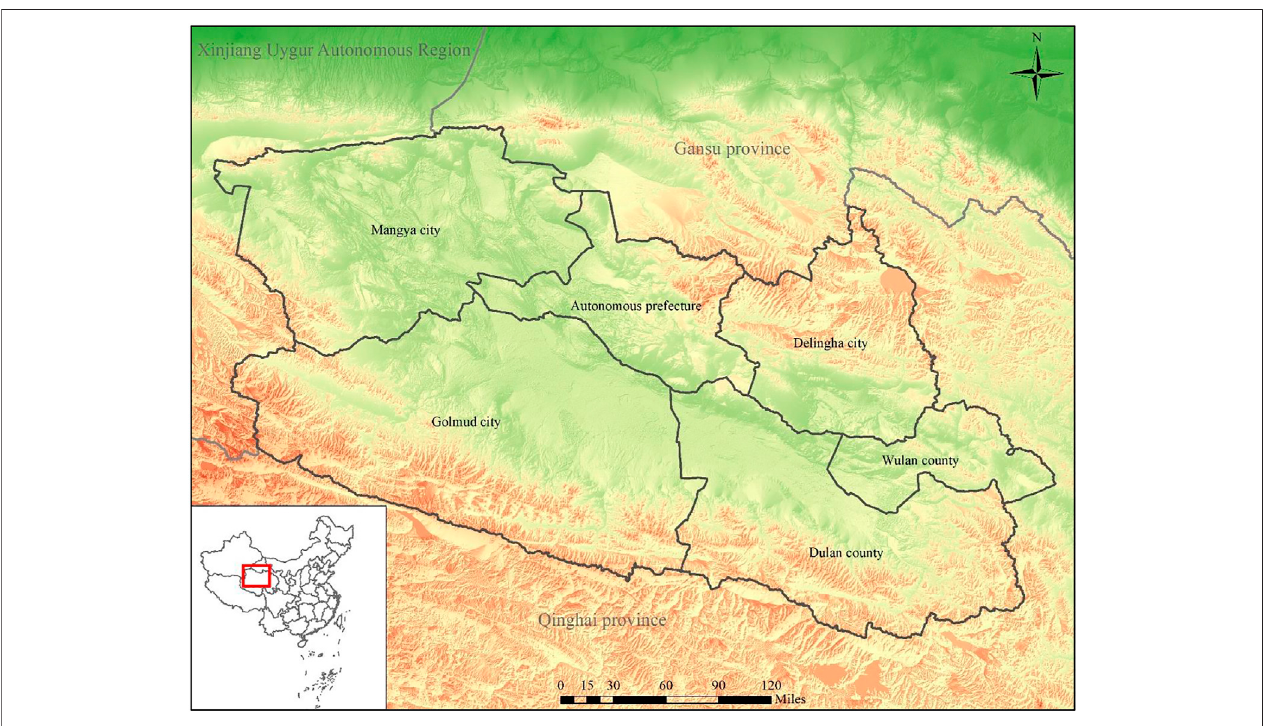
FIGURE 1 | Schematic diagram of the study